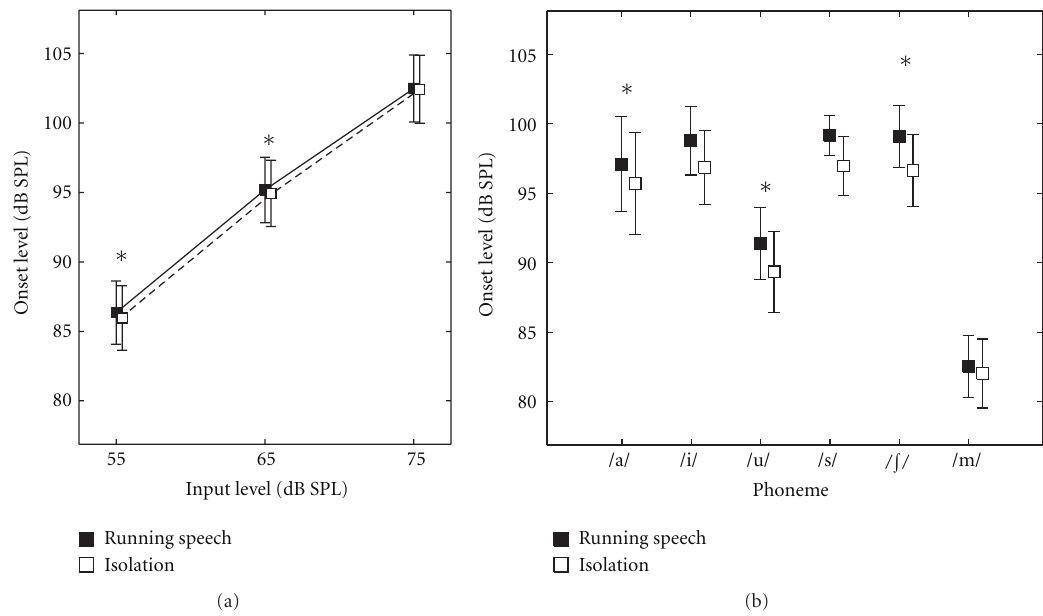
Figure 3: (a) presents variation of phoneme onset level in running speech and isolation context across input levels. (b) presents the same across phonemes. Error bars represent SE. ∗ indicates a statistically significant di ff erence in paired contrasts. The symbols have been o ff set slightly to improve clarity.